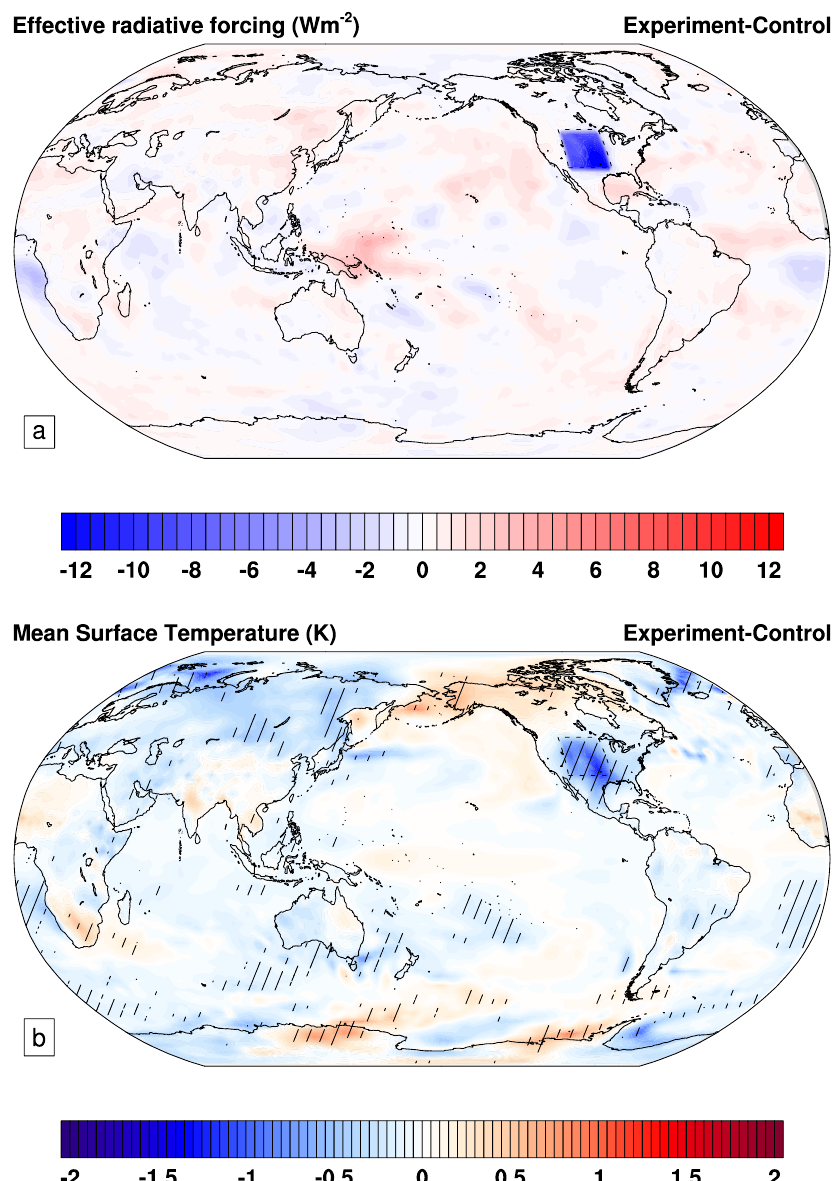
Figure 1. ( a ) Effective radiative forcing (ERF, Wm − 2 ) at the top of the atmosphere; and ( b ) near- surface air temperature (SAT, K) change as 30-year average (experiment − control), ensemble average differences between the sustained RRM and control simulations. Hatched areas are grid cells where the changes are statistically significant at the 90% level according to a t